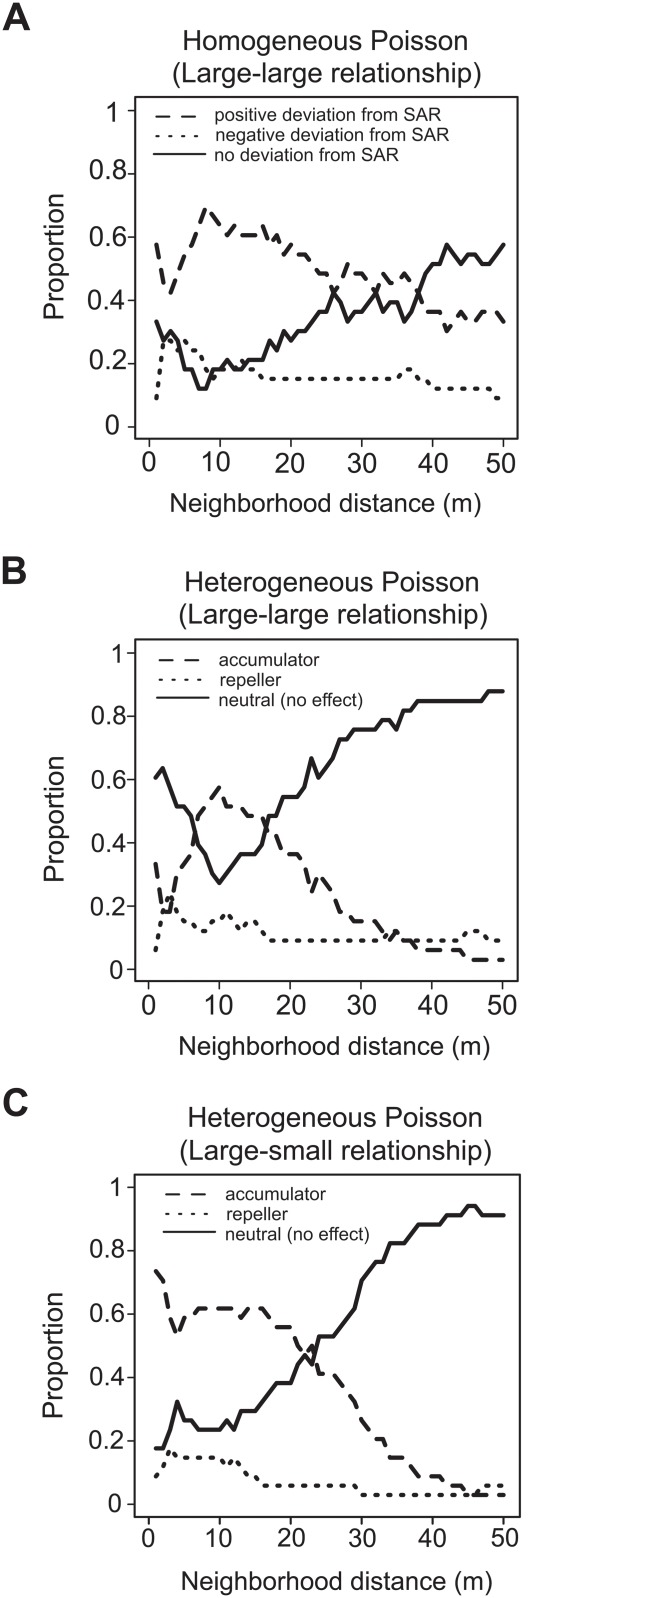
Proportion of species types along neighborhood distances.(A) Homogeneous and (B) heterogeneous Poisson null models for “large-large relationships” and (C) heterogeneous Poisson null model for “large-small relationships.” The broken, dotted, and solid lines indicate the positive, negative, and no deviation from conventional SAR in (A) and the accumulator, repeller, and no effect types in (B, C), respectively.